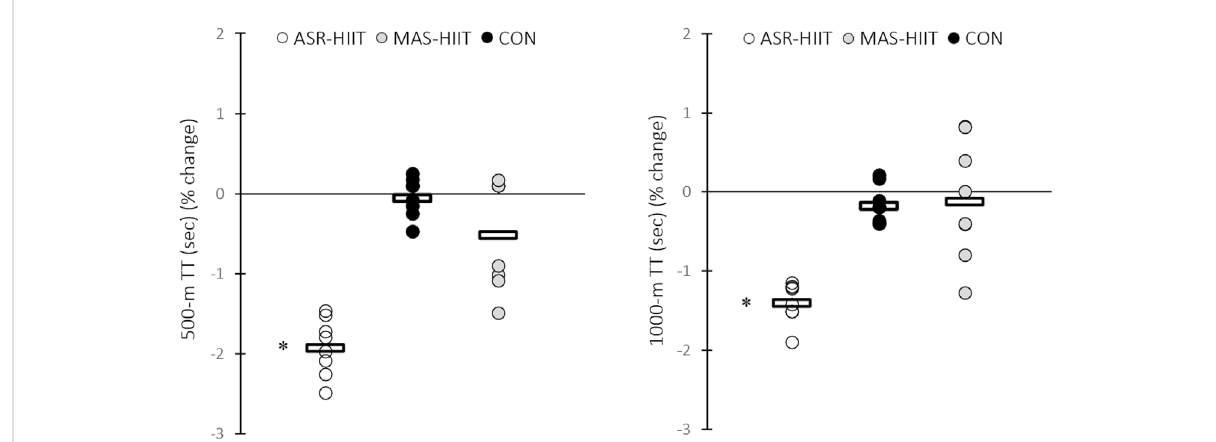
FIGURE 3 Effects of ASR-based HIIT (ASR-HIIT), HIIT based on the MAS (MAS-HIIT), and traditional endurance paddling (CON) on 500-m, and 1000-m time trial performance. Circles indicate individual percent changes from baseline (X-axes) and horizontal bars represent the group mean response. N = 8 for each group. * Denotes signi fi cant difference vs. pre-training ( p ≤